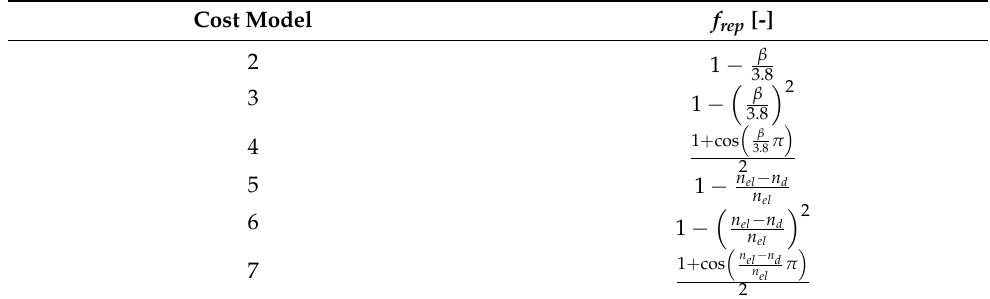
Table 4. Cost models based on [52] adapted in order to account for reliability index directly or for the number of damaged elements.